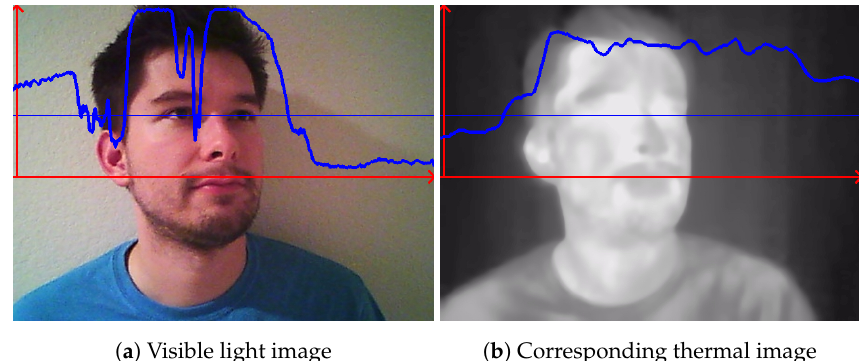
Figure 3. Comparison of pixel values differences (blue plot) at the eye level. Thermal and visible light image taken simultaneously using the FLIR ® One Gen 2 camera. It can be observed that the thermal image is characterized by smoother changes and lower differences between adjacent pixels values than the visible light image. The figure presents one of the authors who has agreed to publish his photography.